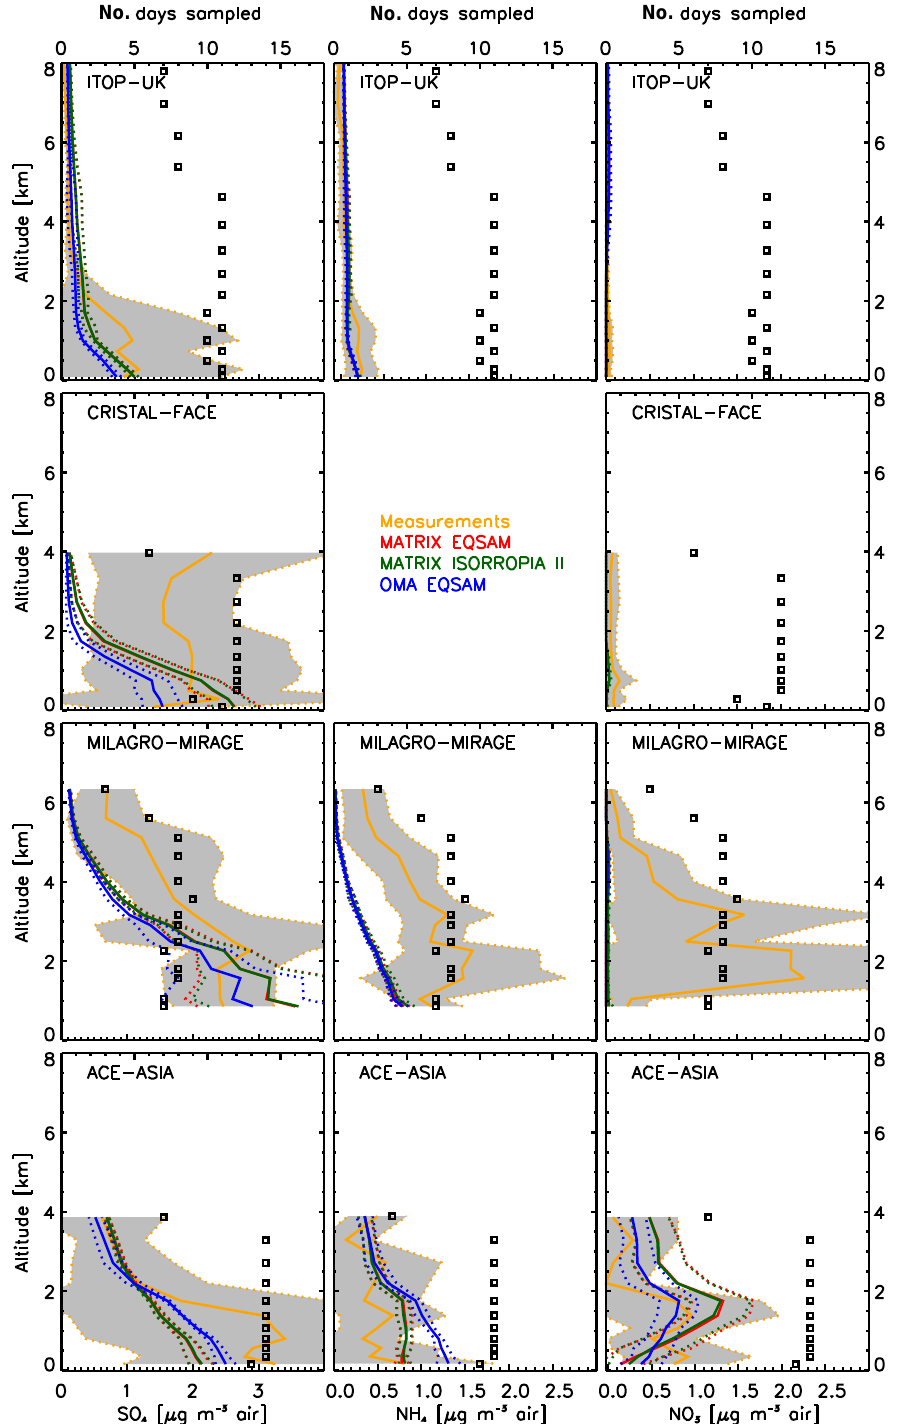
Figure A3. Mean regional concentration profiles. First column is SO 4 , second is NH 4 , and third is NO 3 . Measurements are in orange, MATRIX-EQSAM is in red, MATRIX-ISORROPIA II is in green, and OMA-EQSAM is in